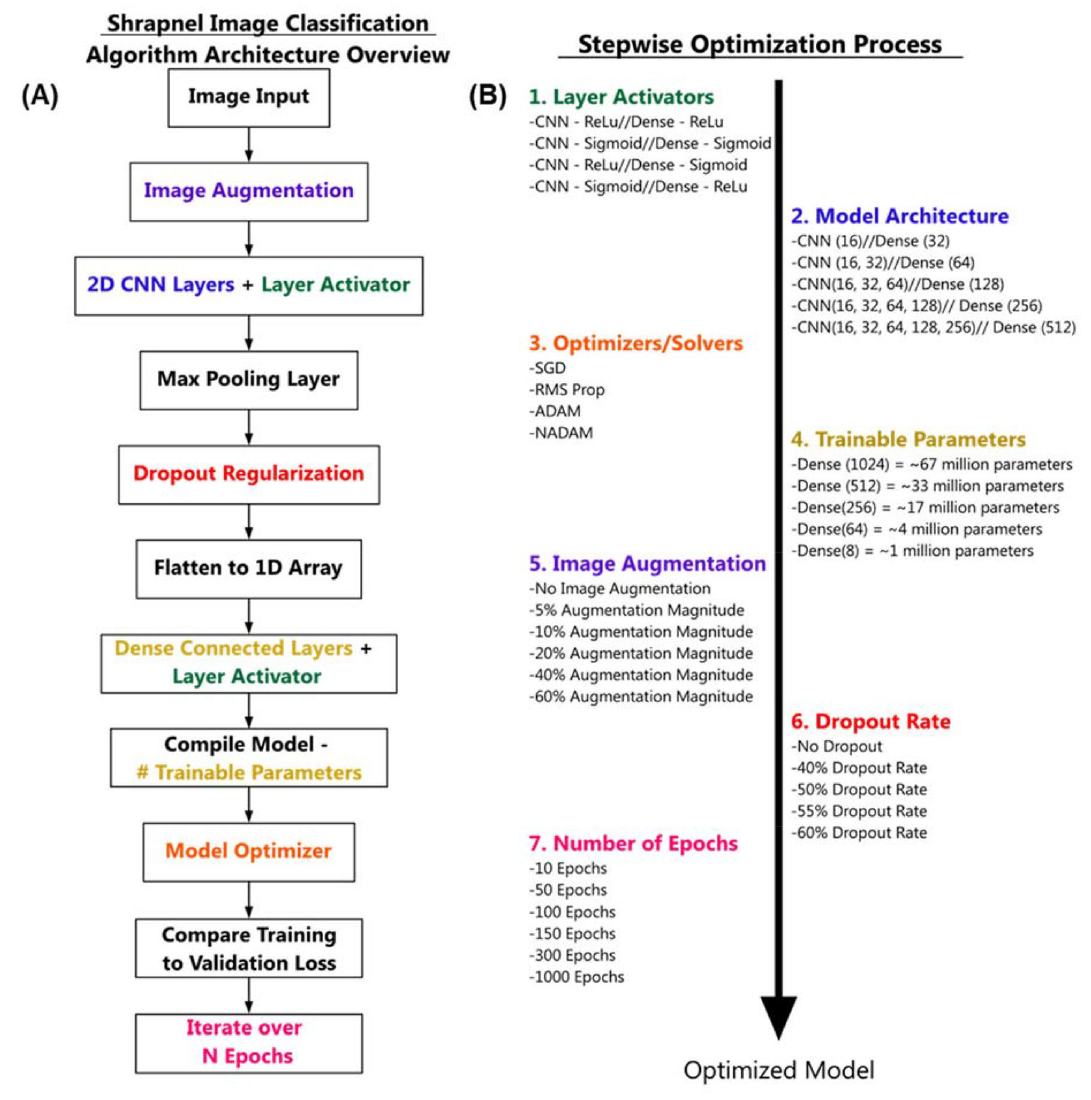
Figure 1. Overview of the Shrapnel Image Classification Framework and Stepwise Optimization Process. ( A ) Process diagram for the image classification algorithm. Images were imported and data augmentation was applied prior to feature identification through the 2D CNN layers and corresponding layer activators. Each CNN layer was followed by a max pooling layer. After 2D CNN layers, a dropout regularization layer was added to mitigate training overfitting. Images were then flattened, and densely connected layers were included until only two categorical outcomes could be selected: shrapnel or baseline. The model was compiled for a summation of the trainable parameters, followed by training optimization by minimizing loss through each epoch iteration. ( B ) Summary of the stepwise features evaluated during model evaluation. Each step is color-coded to its position in the model framework and the parameter variables evaluated are